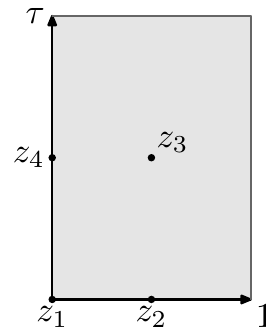
Figure 3 . Fundamental domain of a torus in uniformized